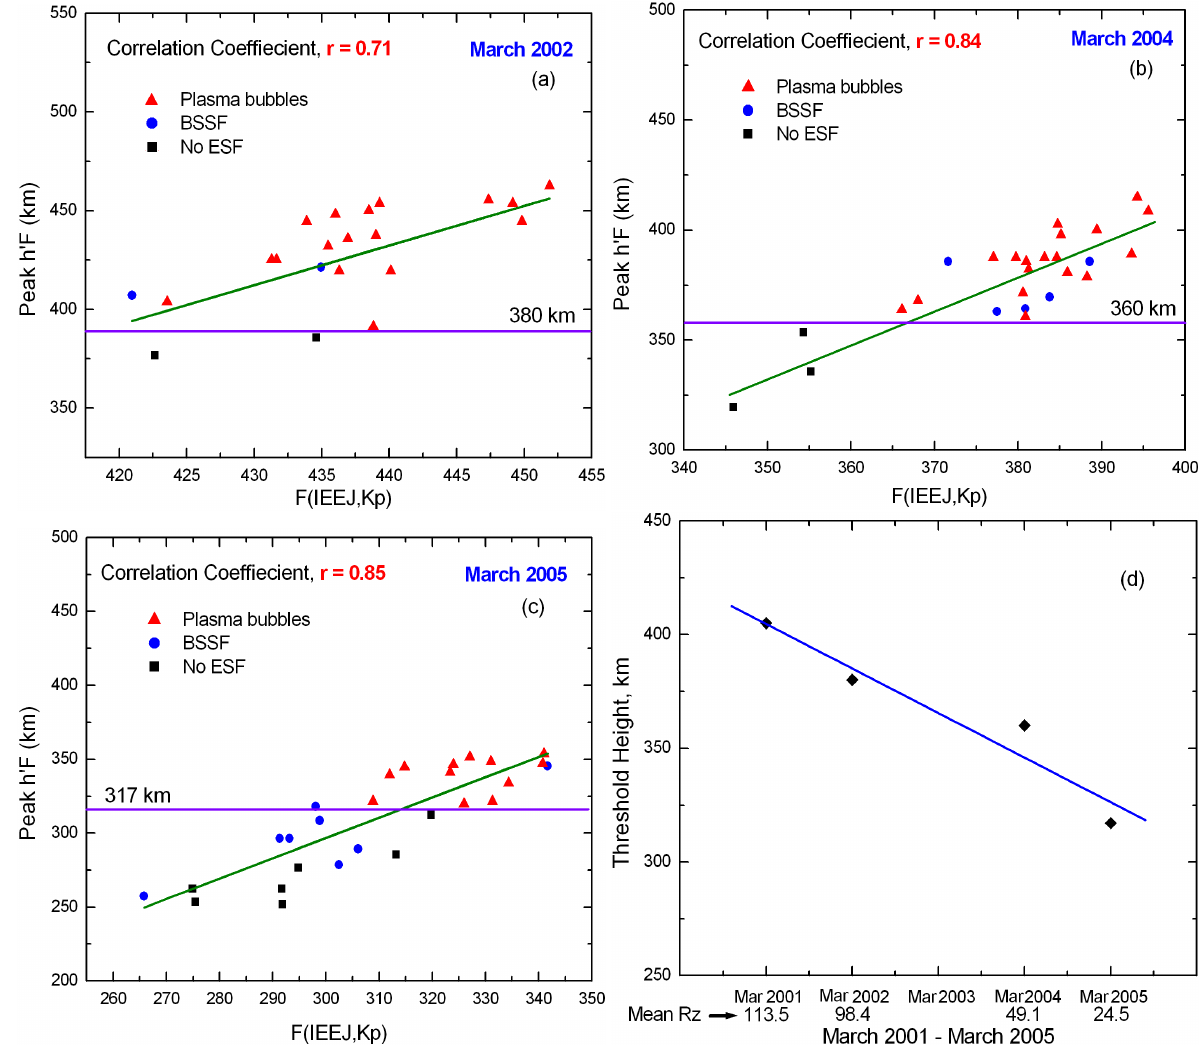
Fig. 4. Plots showing the linear relationship that exists between the post-sunset peak height of the F-layer (peak h 0 F ) and the combined function F (IEEJ, avg K p ) that involves both the Integrated ElectroJet strength and the average K p -Index during the months of (a) March 2002, (b) March 2004 and (c) March 2005, while panel (d) presents the variation of the threshold heights as a function of the monthly mean sunspot (mean Rz ) number, that are needed for the generation of plasma